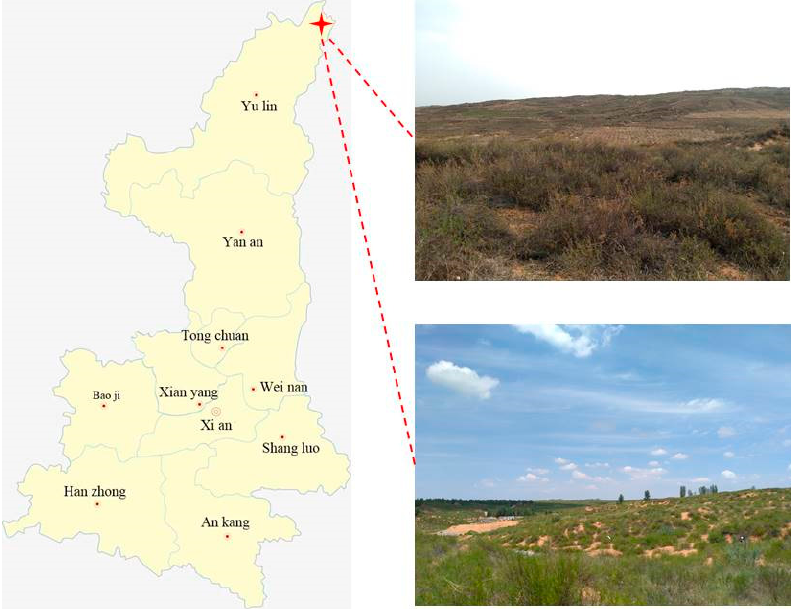
Figure 1. Geographical location of mine field.